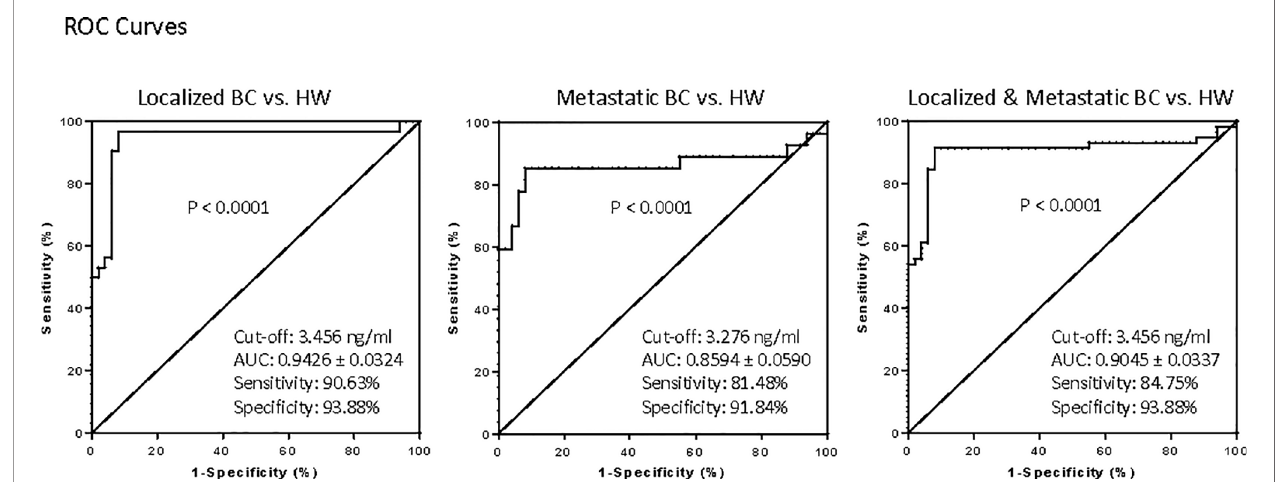
FIGURE 5 | Receiver operating characteristic (ROC) curves for AKR1B10 levels for diagnostic interpretation based on Youden's index (sensitivity plus speci fi city -1).The ROC curves were plotted for localized, metastatic and combined localized and metastatic breast cancer patients against healthy women. The optimal diagnostic value of AKR1B10 in our data set of combined localized and metastatic breast cancer patients was 3.456ng/ml,with a speci fi city of 93.88% and a sensitivity of 84.75%,suggesting its potential diagnostic